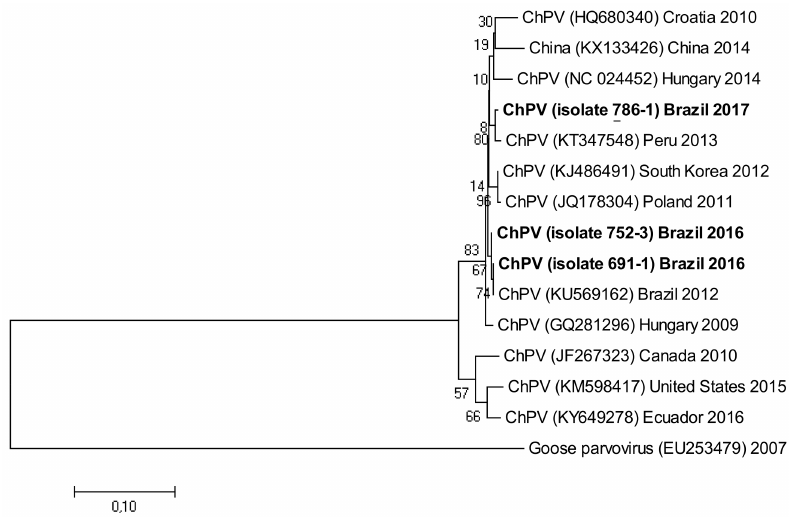
Figure 5. Phylogenetic tree for ChPV strains, was inferred with the neighbor-joining statistical method and based on the partial sequence of NS gene. Numbers along the branches refer to bootstrap values for 1000 replicates. Sequence of Goose parvovirus was used as out-group